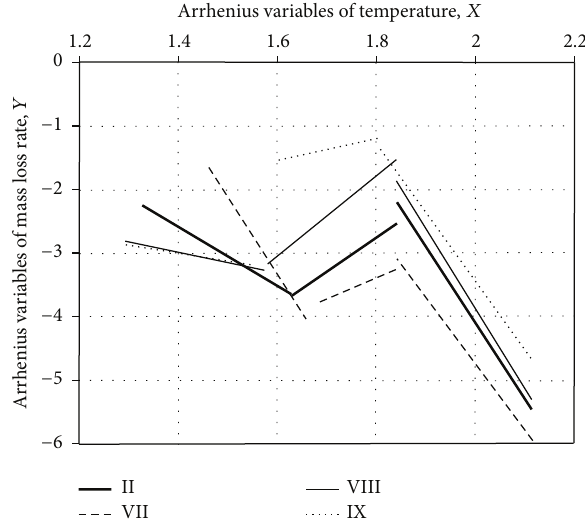
Figure 6: Influence of heating rate (2,5, 5, 10, and 25 ∘ C/min).